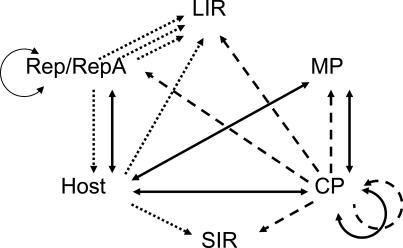
The Network of Known Protein–Protein and Protein–DNA Interactions during a MSV Infection of MaizeRep/RepA indicates the two alternative expression products of the replication-associated protein gene. Solid lines represent specific protein–protein interactions [14,16–18,21,22], dotted lines represent specific protein–DNA interactions [14,16,19–21], and dashed lines indicate CP-DNA interactions of unknown specificity [18–20,22]. For protein–DNA interactions, arrows point from the protein component to the DNA component of the interactions. Rep interacts with the LIR at three distinct sites [14]. CP and Rep form oligomers (solid circular arrows) [14,22]. Although CP must interact with the rest of the genome (including its own gene) during encapsidation, the sequence specificity of these interactions is unknown.